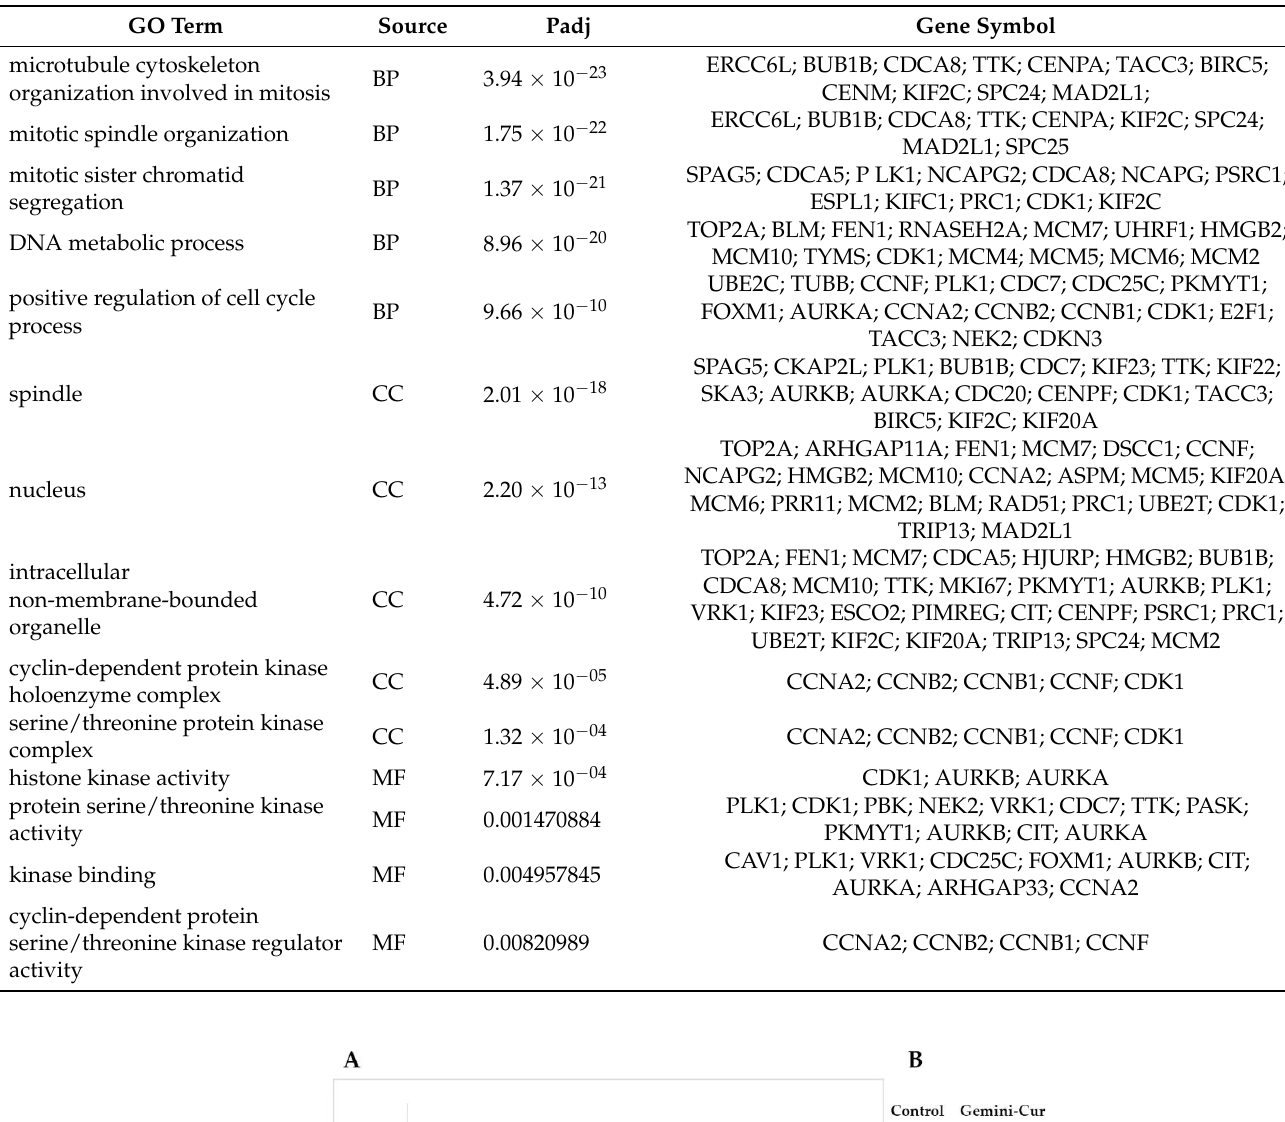
Table 5. The top significantly gene ontology (GO) categories (BP: biological process; CC: cellular component; MF; molecular function) based on upregulated genes with the threshold of |log fold change (FC)| ≥ 2 and a Bonferroni p < 0.05. Padj: adjusted p value.